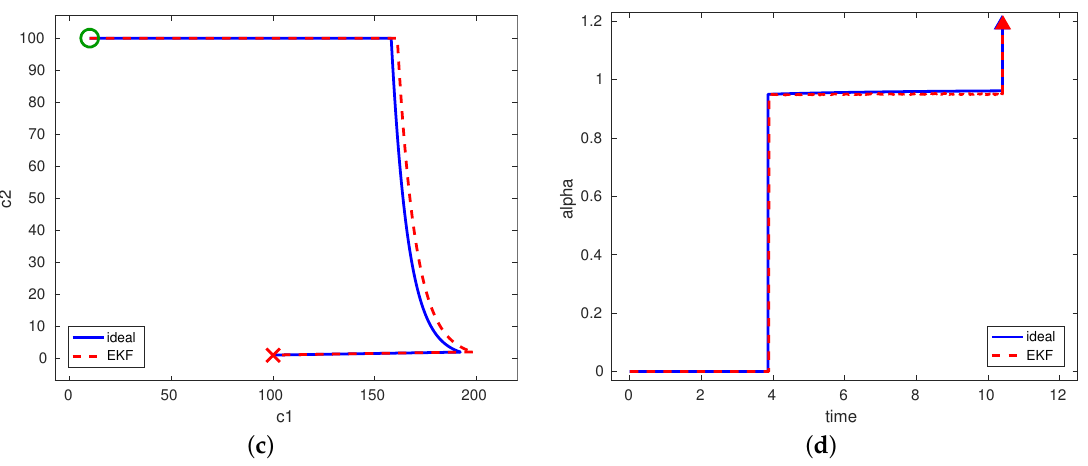
Figure 4. Concentration state diagram and optimal control profile for ideal and estimated fouling parameters ( K = 2 and n = 1.5) by employing the EKF method. ( a ) Measured, ideal and estimated concentrations; ( b ) measured, ideal and estimated flux; ( c ) concentration state diagram; ( d ) optimal control